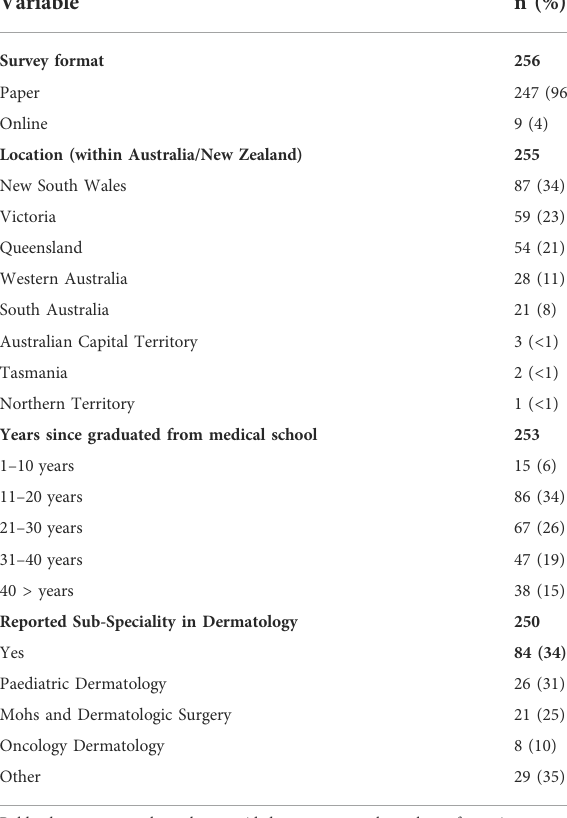
TABLE 1 Participant demographic characteristics ( n = 256). TABLE 2 Current role of genomic medicine for any dermatological